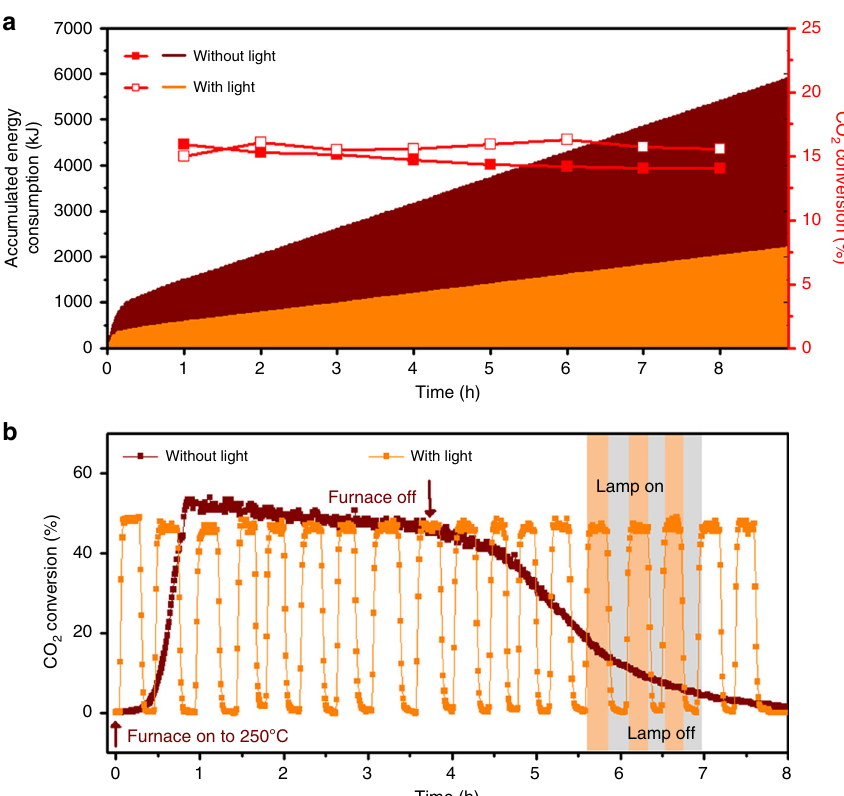
Fig. 4 Energy usage and response for CO 2 hydrogenation with or without light irradiation. a Energy consumption during CO 2 hydrogenation with or without light irradiation. The condition in which both cases showed similar CO 2 conversions was chosen; CO 2 hydrogenation occurred at 180 °C without light, or 150 °C with light. 100 mW laser (532 nm) equipped with a beam expander was used as a light source. The overall power consumption was measured by a power meter. b Response test results for CO 2 hydrogenation with or without light. At t = 0, the temperature of the reactor was set at 100 °C. In the case without light, the heater was turned on, the temperature was maintained for 3 h after it reached 250 °C, and the heater was turned off. In the case with light, a Xe lamp with a light intensity of 63 mW cm − 2 was turned on for 15 min and turned off for 15 min